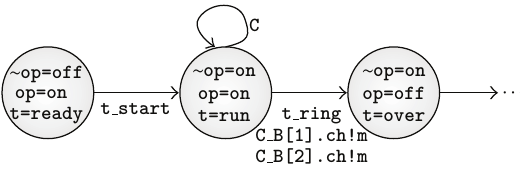
Figure 7: An example model for system 𝐶 𝐴 with a timer.